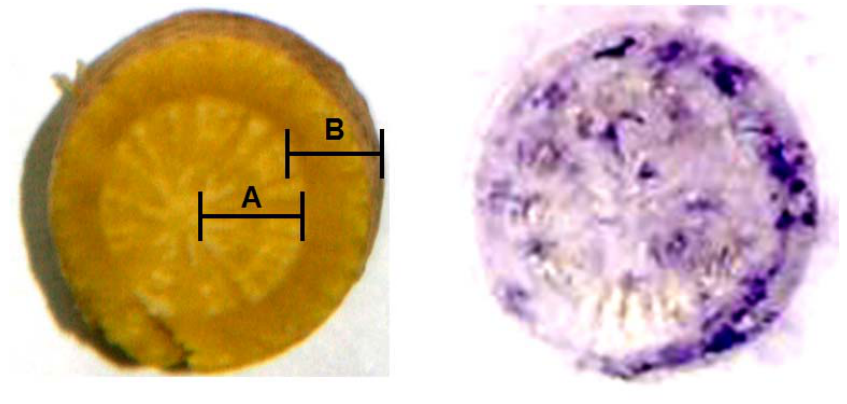
Figure 7. Immunohistochemical analysis of BI in the root of S. baicalensis